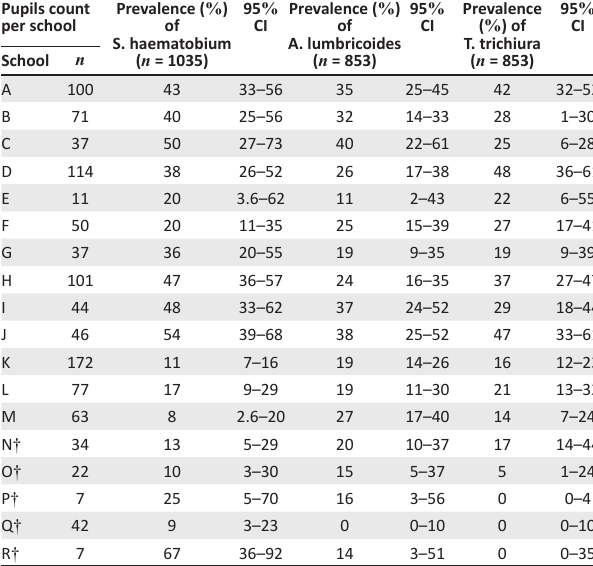
s.d., standard deviation. TABLE 2: Prevalence of Schistosoma haematobium, Ascaris lumbricoides and Trichuris trichiura amongst pupils (aged 10–12 years) attending 18 rural KwaZulu-Natal primary